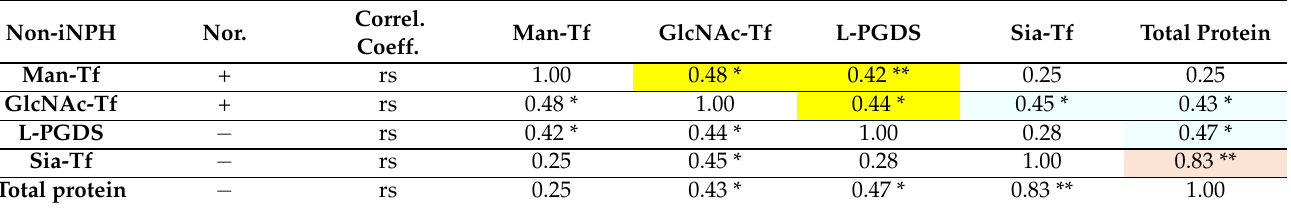
Figure 7. Scatter diagrams and regression lines for marker combinations in non-iNPH patients. Table 6. Correlation coefficients and data normality of markers.